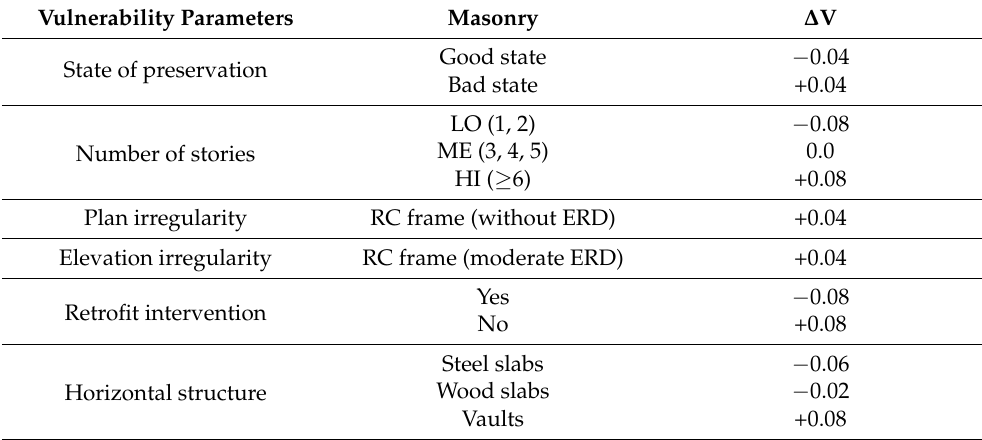
Table 3. Vulnerability modifiers. Reprinted with permission from [35]. Copyright 2020, Polese et